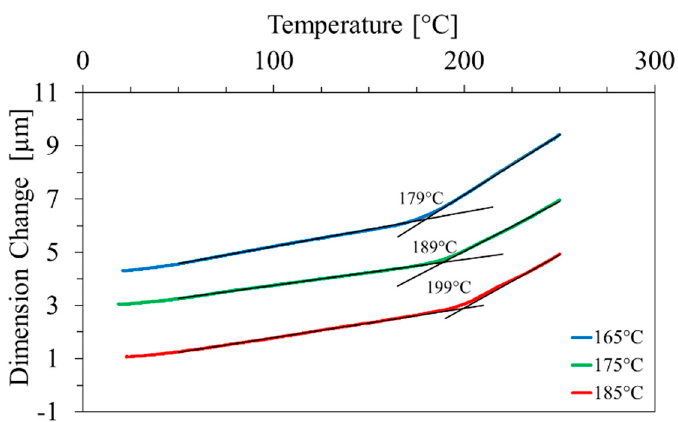
Figure 8. TMA graph of isothermal cured samples, at 165 (blue), 175 (green) and 185 °C (red) for 360 s; T g is determined by intersection of two tangents on TMA curves and indicated for each measurement (curves are artificially shifted along Y axis for better visibility).